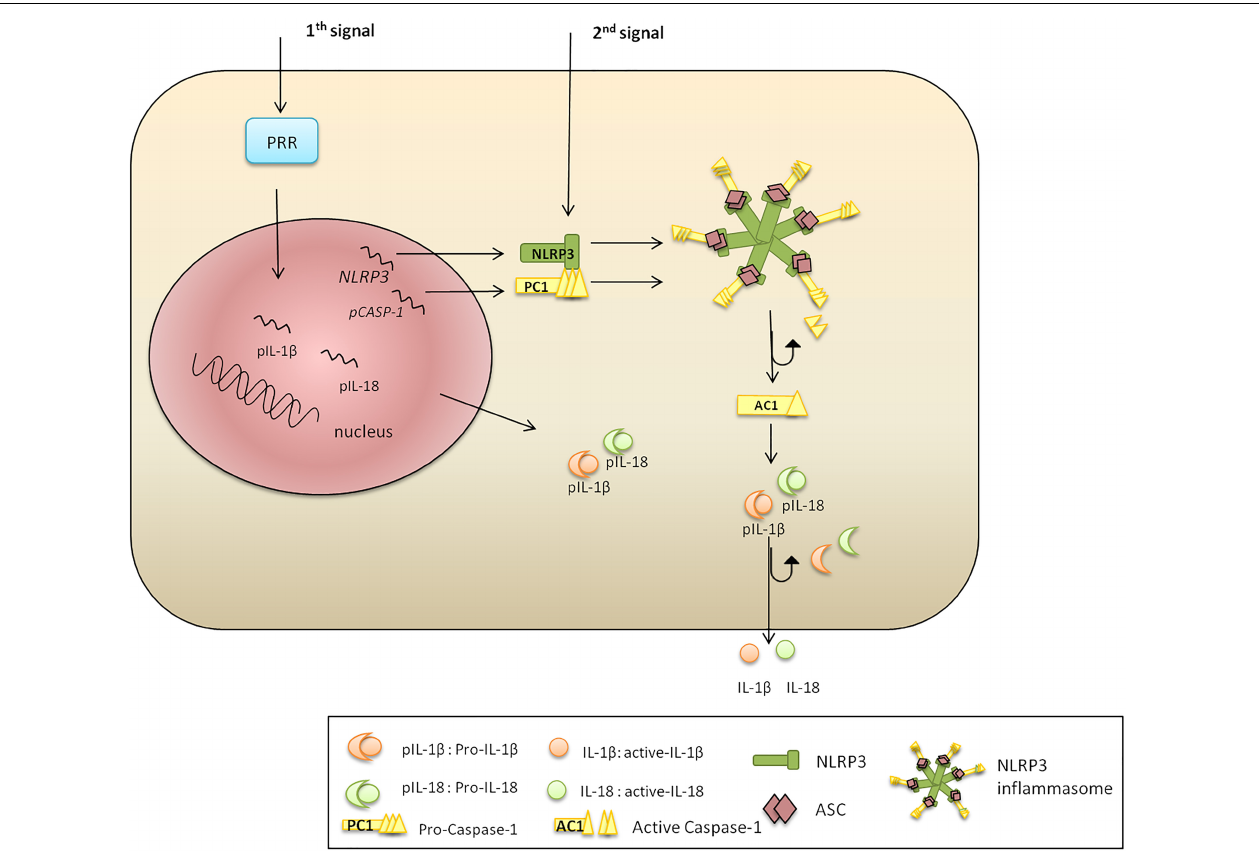
FIGURE 1 | NLRP3 inflammasome activation. There are two signals required for NLRP3 inflammasome activation. Signal 1 is a priming trigger (microbial ligands, cytokines, etc.) required for the upregulation of NLRP3 and pro-IL-1 β transcription and protein synthesis. Signal 2 is an activation trigger (ATP, toxins, viral RNA, etc.) which is essential for formation of an active NLRP3 inflammasome. The second stimulus promotes NLRP3, PC1, pro-IL-1 β , and pro-IL-18 protein synthesis. The N-terminal NBD of NLRP3 polymerizes initiating PYD–PYD oligomerization with ASC. The CARD of ASC recruits PC1, which become cleaved liberating AC1. Inflammatory AC1 liberates functional IL-1 β and IL-18, pleotropic cytokines regulating inflammation and innate immune